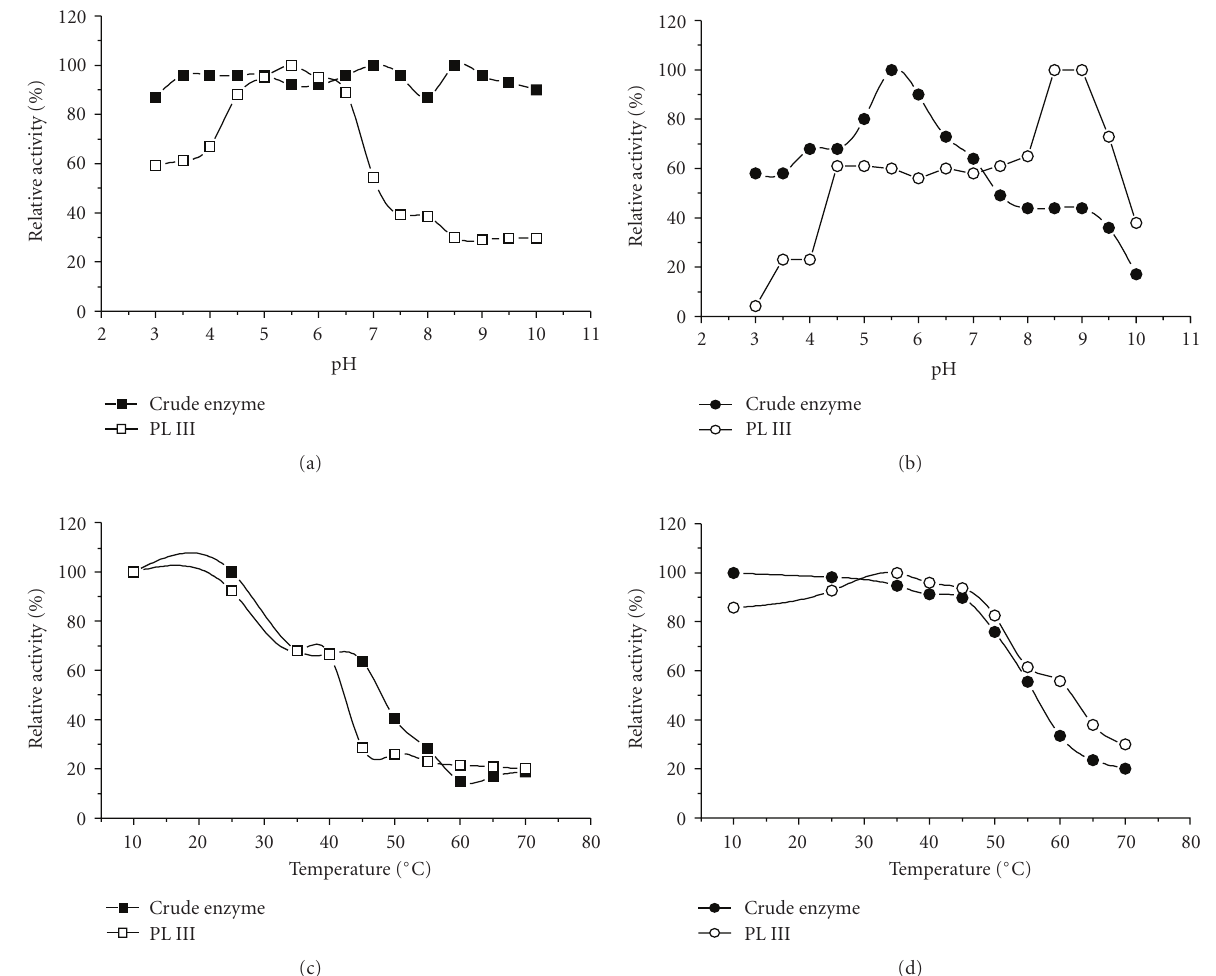
Figure 5: Physicochemical profiles of stability of PLs obtained from P. viridicatum by SSF (a; c) and SmF (b; d). ( / ) = crude enzyme; ( / ) = fraction III obtained by Sephadex-G75